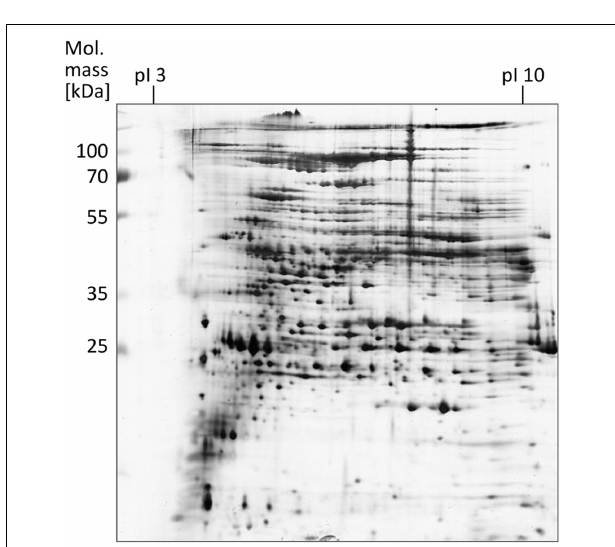
FIGURE 3 | EPS proteins of S. acidocaldarius biofilms separated by 2 DE and visualized by silver staining . EPS were isolated from biofilms collected from Brock medium plates after 4days of incubation at 78°C. A total of 200 μ g EPS protein were applied for IEF (non-linear IPG strips). Molecular mass marker: PageRuler Prestained Protein Ladder (Fermentas).